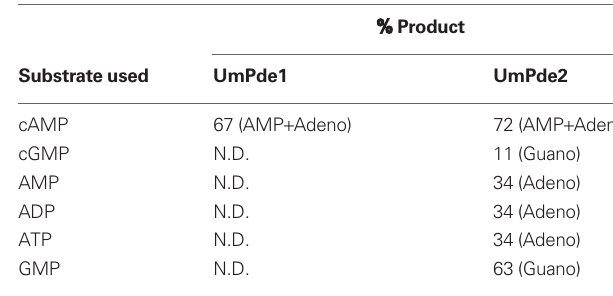
Table 1 | Substrate specificity for umPde1 and umpde2.